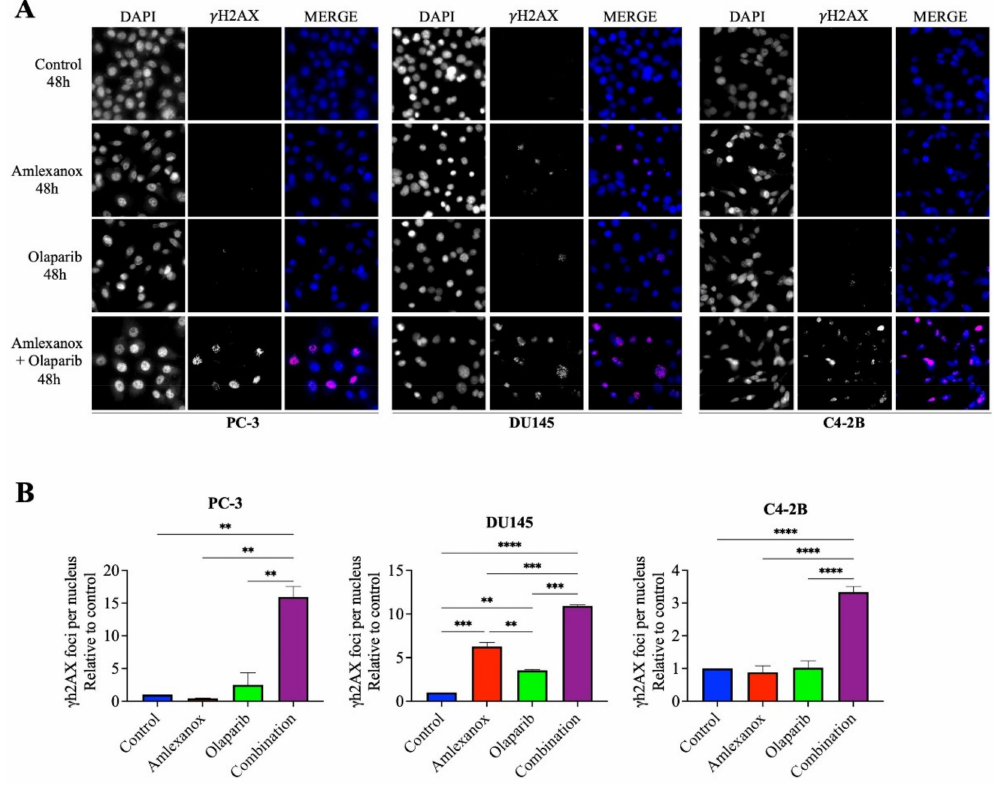
Figure 2. Amlexanox enhances Olaparib-induced DNA damage. Representative images ( A ) and quantification ( B ) of γ H2AX foci in CRPC cells treated 100 µ M Amlexanox and/or 10 µ M Olaparib for 48 h. Cells were fixed and γ H2AX foci (red) and DAPI (blue) were stained by immunofluorescence. Pictures were taken using a Zeiss microscope and the number of γ H2AX foci per nuclei was counted using ImageJ. Each experiment was repeated three times. Statistical significance was determined by two-way ANOVA. ** p < 0.001; *** p < 0.0001; **** p <